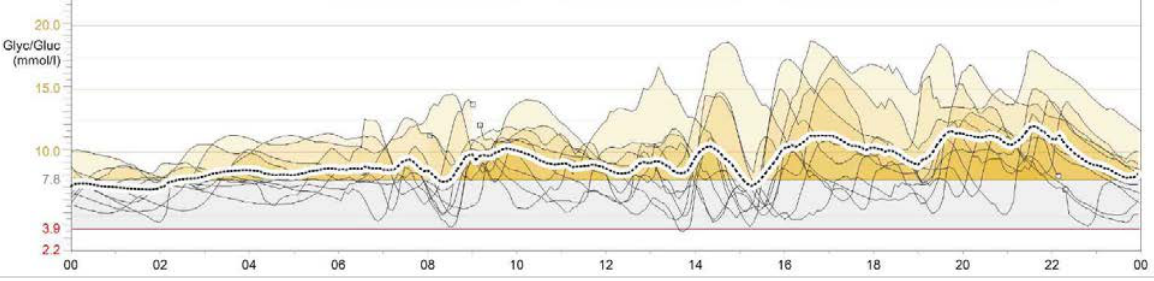
Figure 3: Continuous glucose monitoring with continuous subcutaneous insulin infusion via a sensor-augmented insulin pump with automated insulin suspension. Insulin boluses administered 15 minutes before the start of the meals. Solid lines represent the record of six individuals and consecutive days. The dotted line is the average of the six recorded days. The shaded zone represents the target glucose